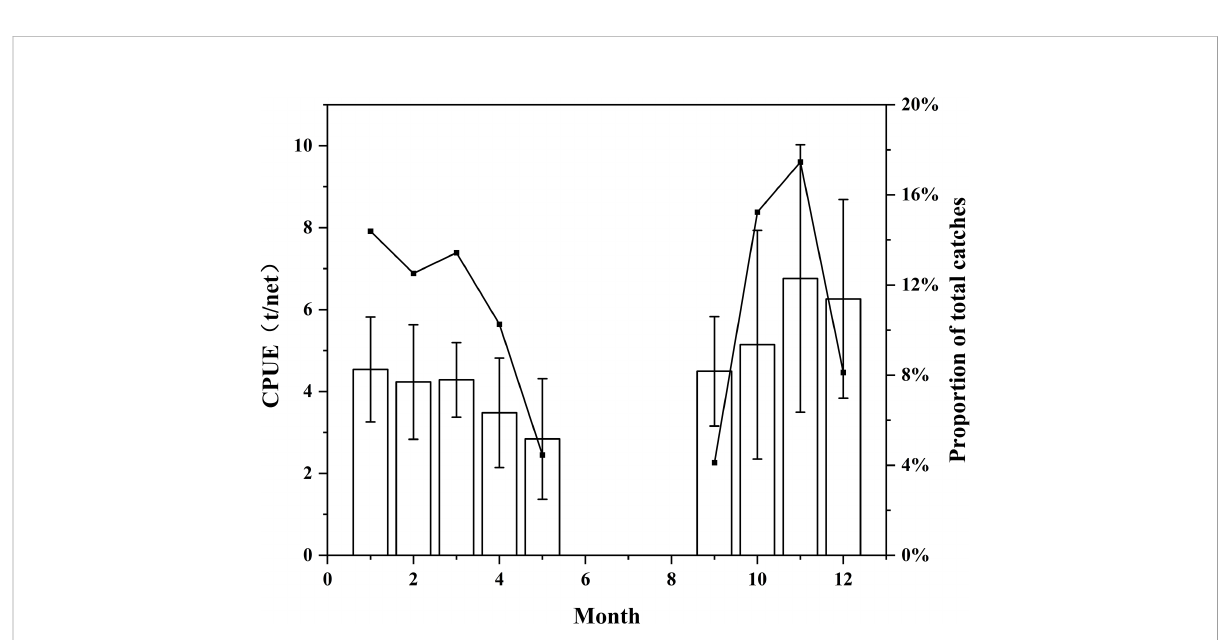
FIGURE 3 Variation in the proportion of total catches (line) and CPUE (bar) of light falling gear in the Northwest Indian Ocean on a monthly scale (mean ± standard